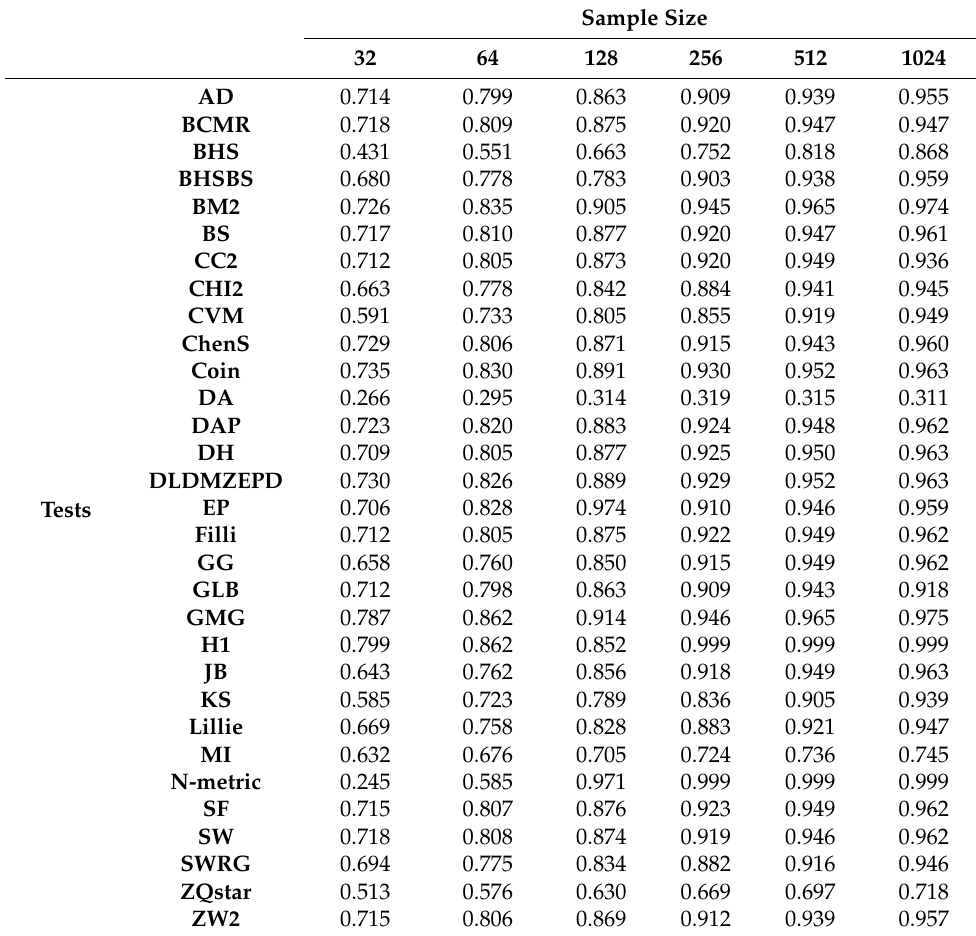
Table 1. Average empirical power obtained for a group of symmetric distributions.